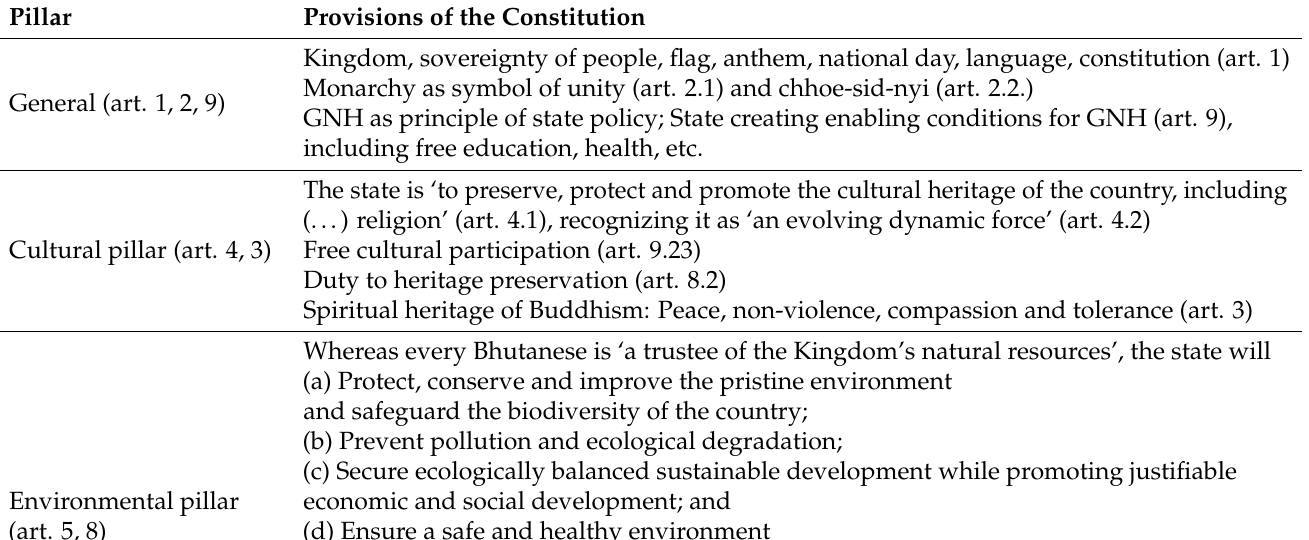
Table 5. Constitution and GNH pillars (Van Norren